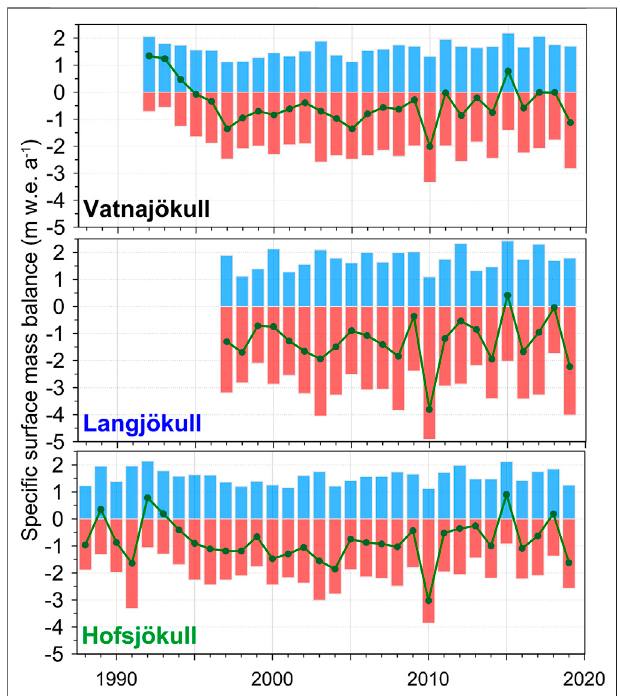
FIGURE 2 | Mean speci fi c surface mass-balance records of the three largest glaciers in Iceland obtained with glaciological method ( in situ surveys). The mass-balance measurements have been conducted at ∼ 60, ∼ 25, and ∼ 25 locations since 1991/92, 1996/97, and 1987/88 for Vatnajökull, Langjökull, and Hofsjökull, respectively. Measurements by Institute of Earth Sciences, University of Iceland, and the National Power Company of Iceland (Langjökull and Vatnajökull) and the Icelandic Meteorological Of fi ce (Hofsjökull).